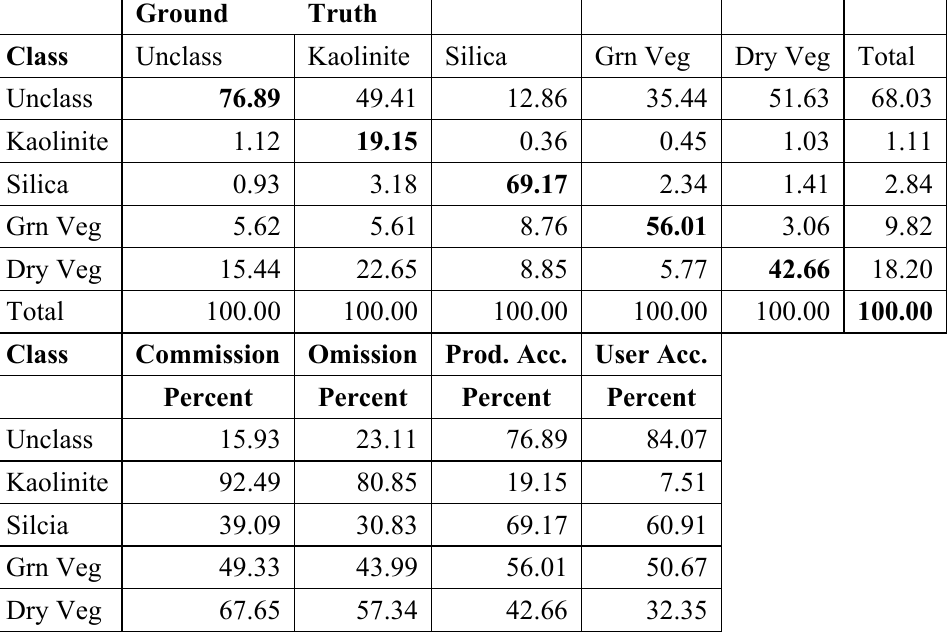
Table 3. Confusion matrix for Yellowstone, Wyoming, 15 m versus 60 m